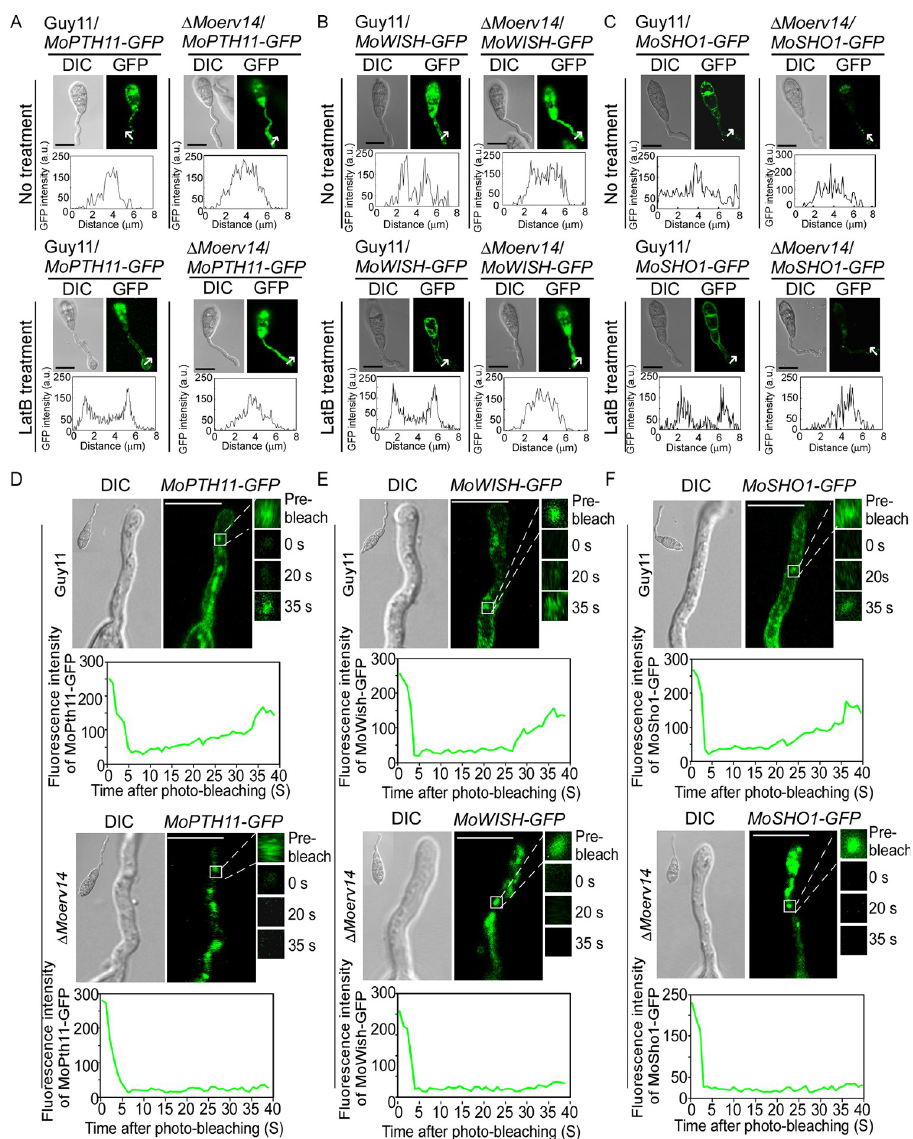
Fig 8. MoErv14 regulates trafficking of MoPth11-GFP, MoWish-GFP, and MoSho1-GFP during conidial germination. (A) MoPth11-GFP localization patterns in germ tubes of Guy11 and Δ Moerv14 mutant at 3 h and MoPth11-GFP localization patterns with LatB treatment in germ tubes of Guy11 at 3 h. Bars = 10 μ m. (B) MoWish- GFP localization patterns in germ tubes of Guy11 and Δ Moerv14 mutant at 3 h. MoWish-GFP localization patterns with LatB treatment in germ tubes of Guy11 at 3 h. Bars = 10 μ m. (C) MoSho1-GFP localization patterns in germ tubes of Guy11 and Δ Moerv14 mutant at 3 h. MoSho1-GFP localization patterns with LatB treatment in germ tubes of Guy11 at 3 h. Bars = 10 μ m. (D) Representative images of FRAP analysis for diffusion at MoPth11-GFP localized regions in germ tubes of Guy11 and Δ Moerv14 . The fluorescence of MoPth11-GFP significantly recovered at 35 s post- photobleaching in Guy11 but not in Δ Moerv14 . The FRAP curves of MoPth11-GFP localized regions in Guy11 and Δ Moerv14 . 20 regions from different cells were subjected to FRAP analysis for each strain. Intervals: 5 s. Bars = 5 μ m. (E) Representative images of FRAP analysis for diffusion at MoWish-GFP localized regions in germ tubes of Guy11 and Δ Moerv14 . The fluorescence of MoWish-GFP significantly recovered at 35 s post-photobleaching in Guy11 but not in Δ Moerv14 . The FRAP curves of MoWish-GFP localized regions in Guy11 and Δ Moerv14 . 20 regions from different cells were subjected to FRAP analysis for each strain. Intervals: 5 s. Bars = 5 μ m. (F) Representative images of FRAP analysis for diffusion at MoSho1-GFP localized regions in germ tubes of Guy11 and Δ Moerv14 . The fluorescence of MoSho1-GFP significantly recovered at 35 s post-photobleaching in Guy11 but not in Δ Moerv14 . The FRAP curves of MoSho1-GFP localized regions in Guy11 and Δ Moerv14 . 20 regions from different cells were subjected to FRAP analysis for each strain. Intervals: 5 s. Bars = 5 μ